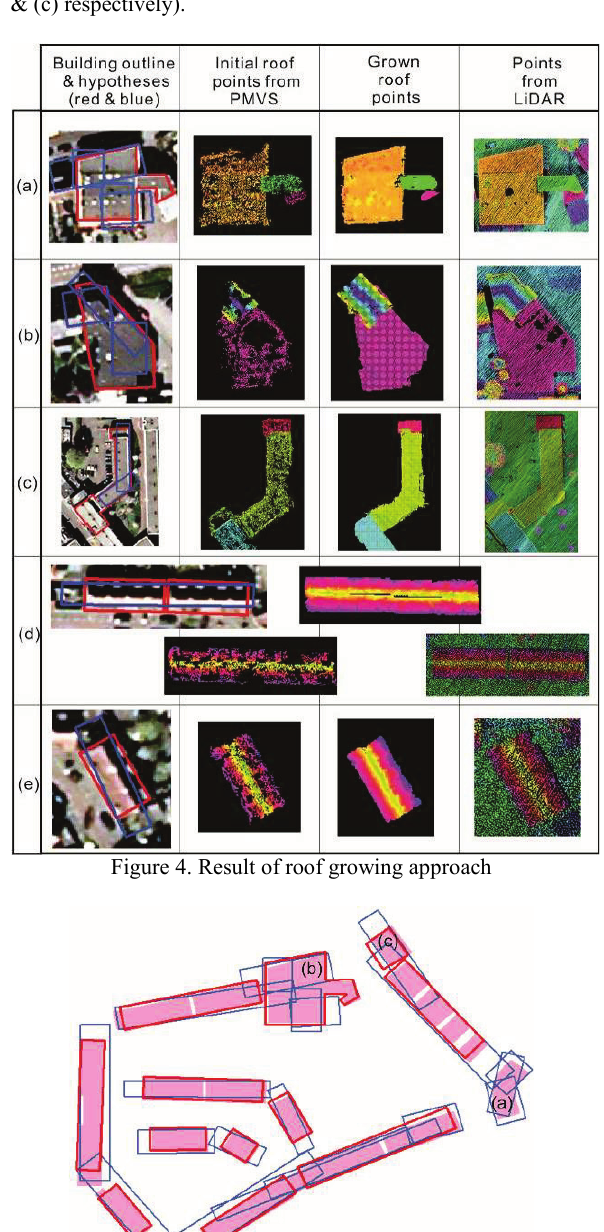
Figure 5. Comparison of outline (red line) with cadastral map (solid pink) and previous box model (blue